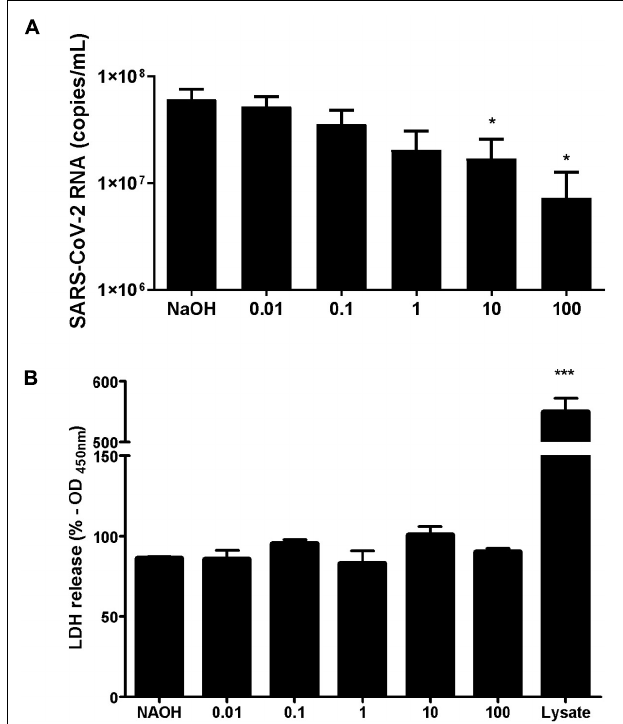
FIGURE 2 | Hypericin inhibits replication of SARS-CoV-2 in vitro at non-cytotoxic concentrations. (A) Inhibition of SARS-CoV-2 replication by hypericin. Vero E6 cells were infected with SARS-CoV-2 for 1 h at a MOI of 0.01. Infected cells were then treated with increasing concentrations of hypericin (0.01–100 µ M) for 48 hpi or NaOH (2 mM) as vehicle control. Viral RNA was quantified from the collected supernatants at 48 hpi by real time qRT-PCR. Bars show mean and SEM of four independent experiments. One-way ANOVA with Dunnett’s multiple comparison tests, * p < 0.05. (B) Cytotoxicity of hypericin in Vero E6 cell line. Presence of LDH was measured in the supernatant of cells treated with the indicated concentrations of the compound for 48 h. Cell lysate was used as a positive control. Bars show mean and SEM of three independent experiments. One-way ANOVA with Dunnett’s multiple comparison tests, *** p <